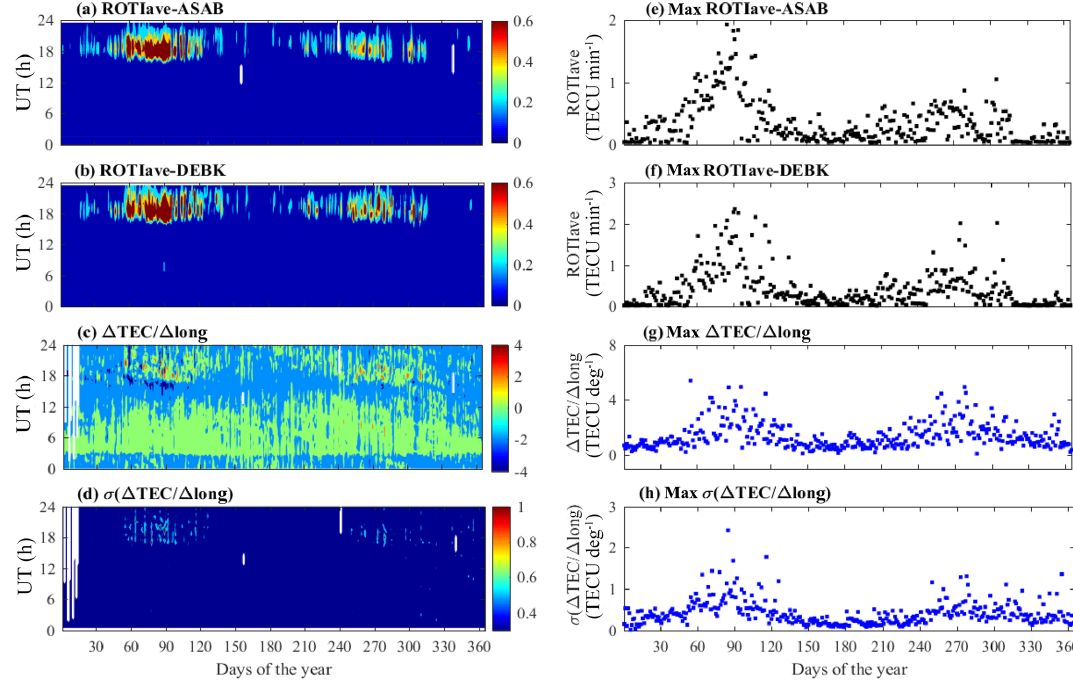
Figure 7. Annual and daily maximum value variation of (a, b) ROTI ave over Asab (ASAB), (c, d) ROTI ave over Debark (DEBK), (e, f) spatial gradient of TEC ( (cid:49) TEC /(cid:49) long), (g, h) standard deviation of gradient of TEC σ((cid:49) TEC /(cid:49) long ) in the year 2014. The ROTI ave in TECUmin − 1 and (cid:49) TEC /(cid:49) long in TECUdeg − 1 is indicated in color bar. Local time (LT) = UT + 3h.